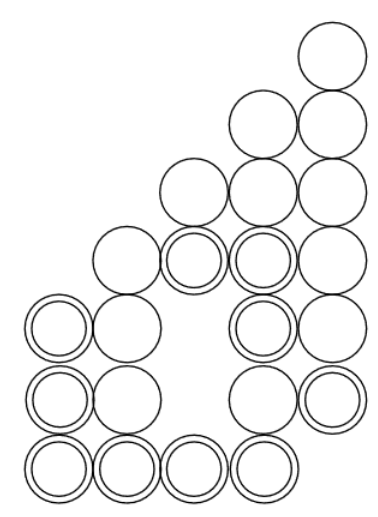
Figure 10. Here is an example of an activation diagram which is not a chinampa. The copies of pyramid p 2, i , t q at the bottom are next to each other, and as a consequence, all vertices in the hole are internally